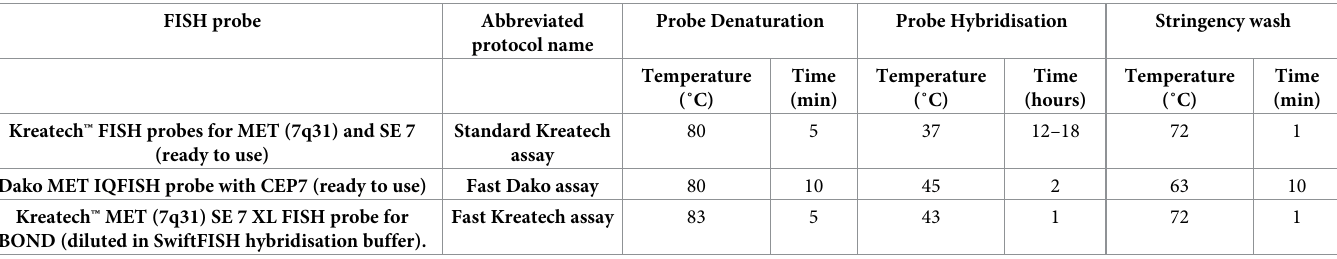
Table 1. Summary of FISH